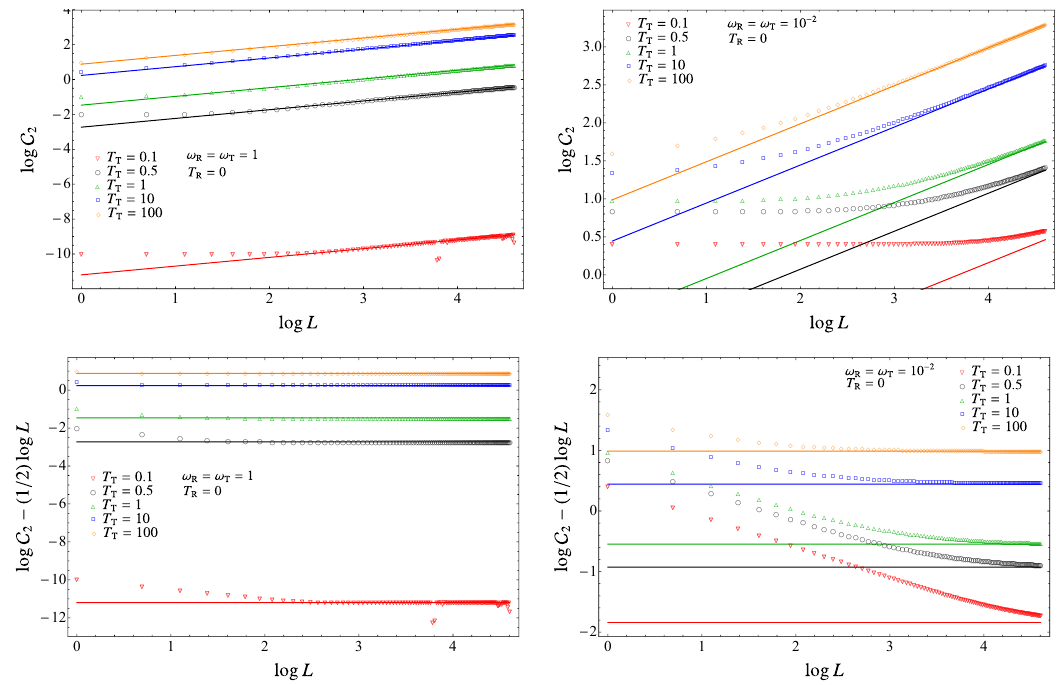
= ω , ˜ ω = ω , e T = T and e T = T . In all R R T T R R T T are considered. Top panels: ω = ω = 1 (left) T R T = 0 and various values of T . In the left panel R T